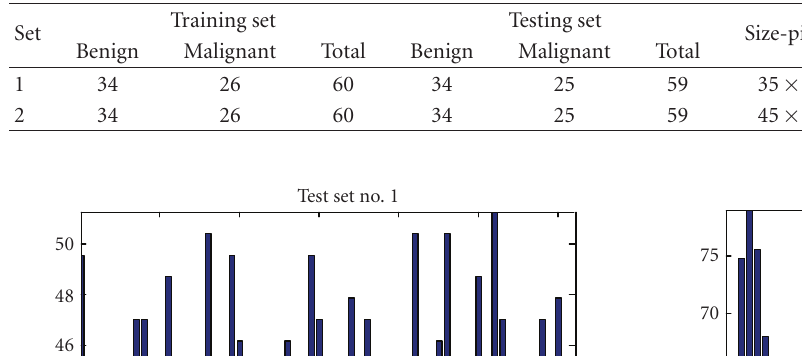
Table 3: Computer-aided diagnosis using CADD algorithm.